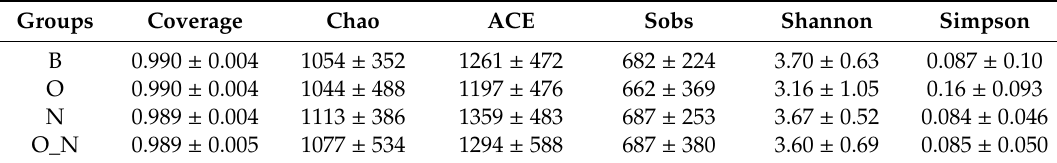
Table 2. The alpha diversity of samples (mean ± SD).